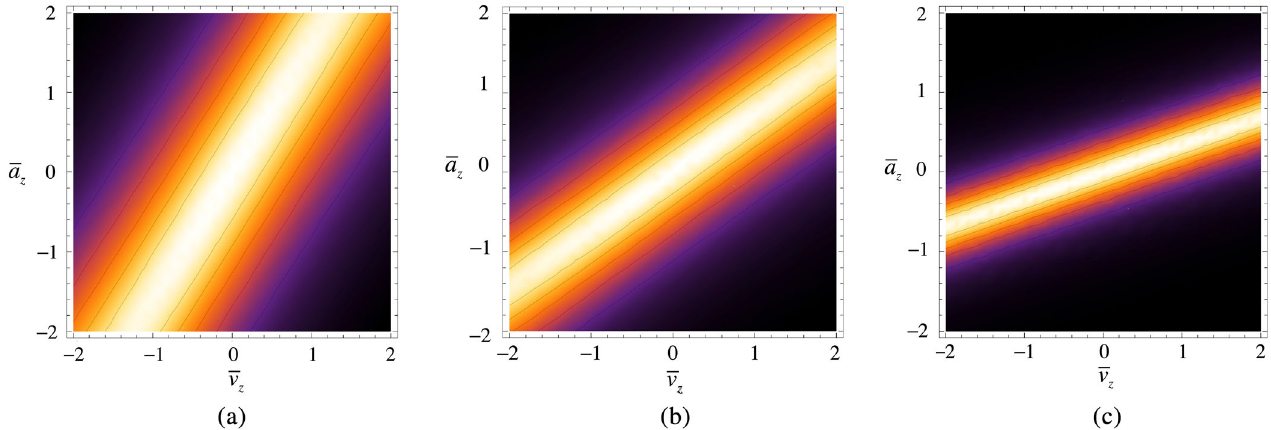
FIG. 3. Plots of the normalized density at z ¼ 0 , x ¼ 0 . 1 r plasma oscillations: (a) ω contour lines are spaced by